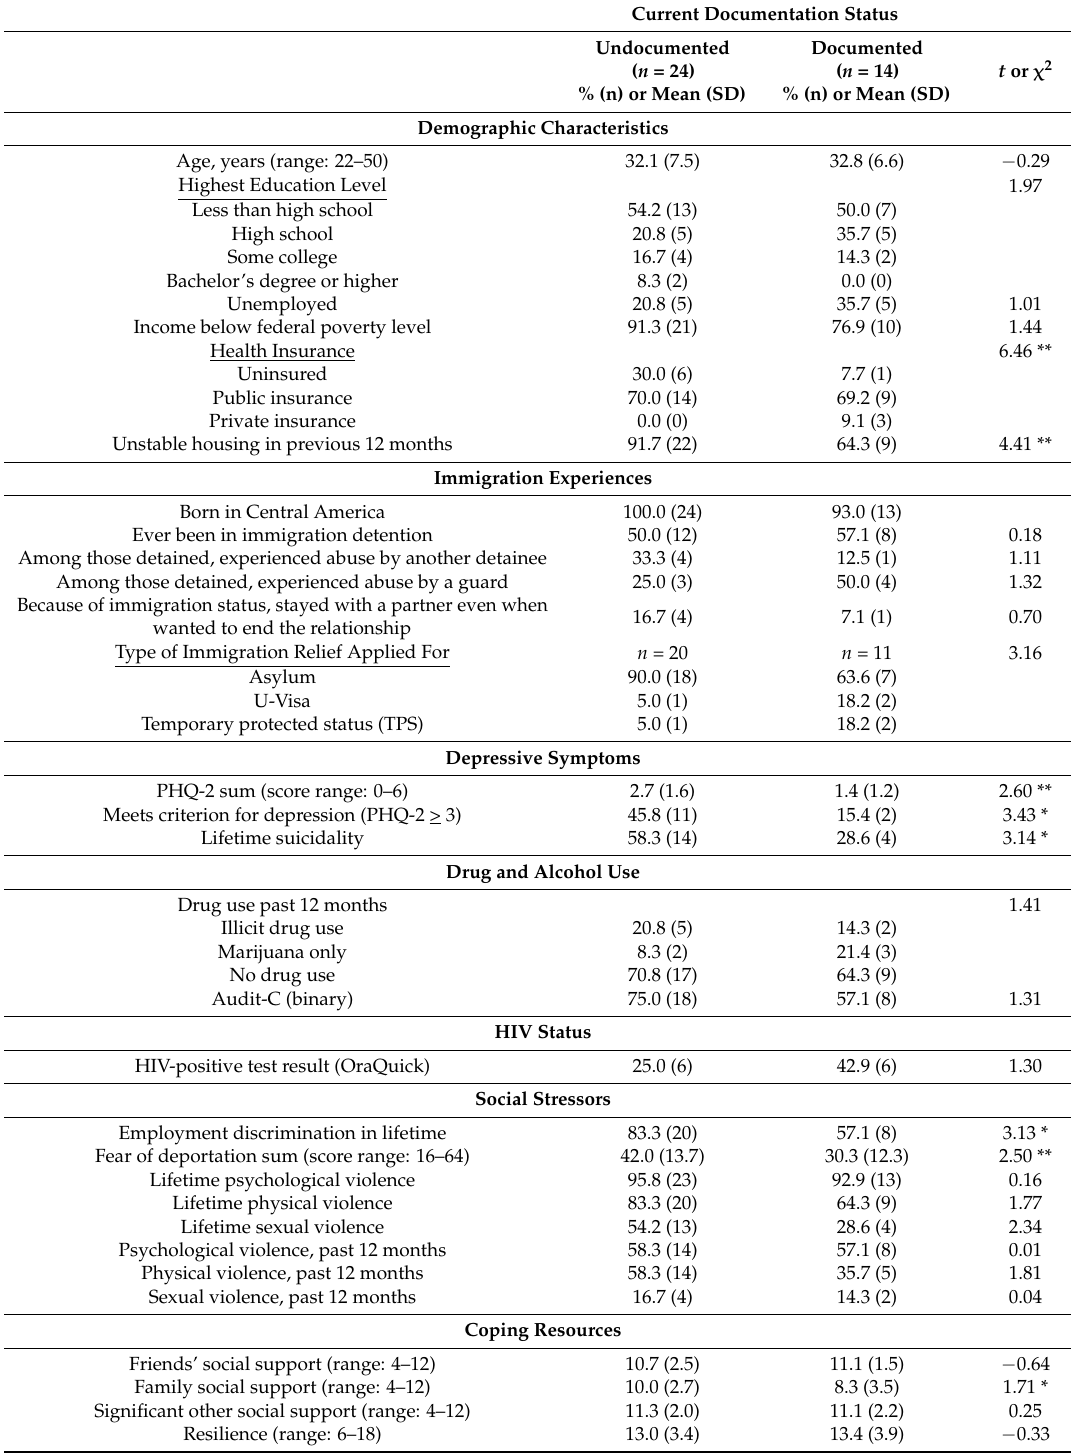
Table 1. Characteristics and Experiences of Immigrant Latina Transgender Women ( n = 38) in the STROBE Study, Washington, DC, USA,